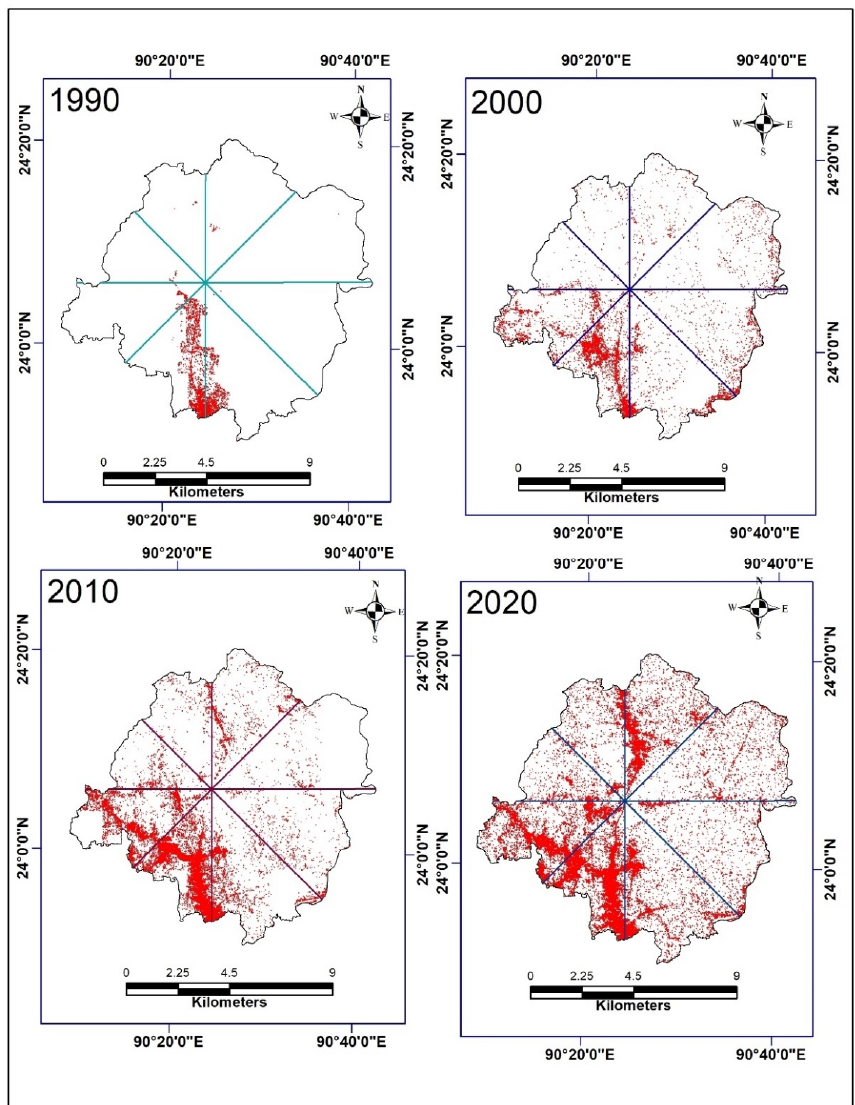
Atmosphere 2021 , 12 , 1353 Figure 8. Direction of growth of the built-up area. Figure 8. Direction of growth of the built-up area.